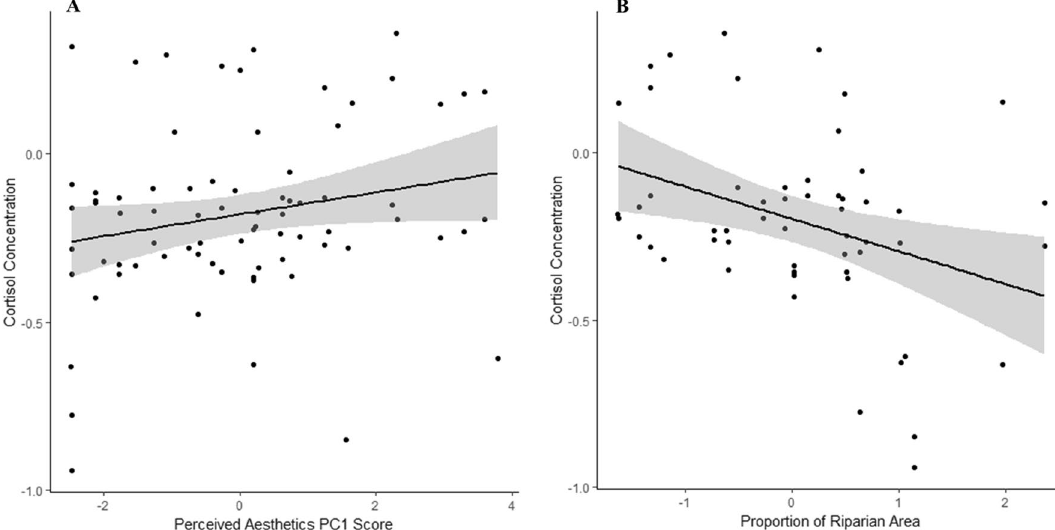
Figure 1. The relationship between the change in cortisol (µg/dL) and both perceived aesthetics and riparian area with best fit lines and standard error (n = 55). ( A ) Cortisol significantly increased after recreating in low aesthetically perceived landscapes. ( B ) Cortisol significantly decreased after recreating in more riparian areas. Both figures are plotted against the residual change in cortisol when controlling for either aesthetic PC1 score or riparian